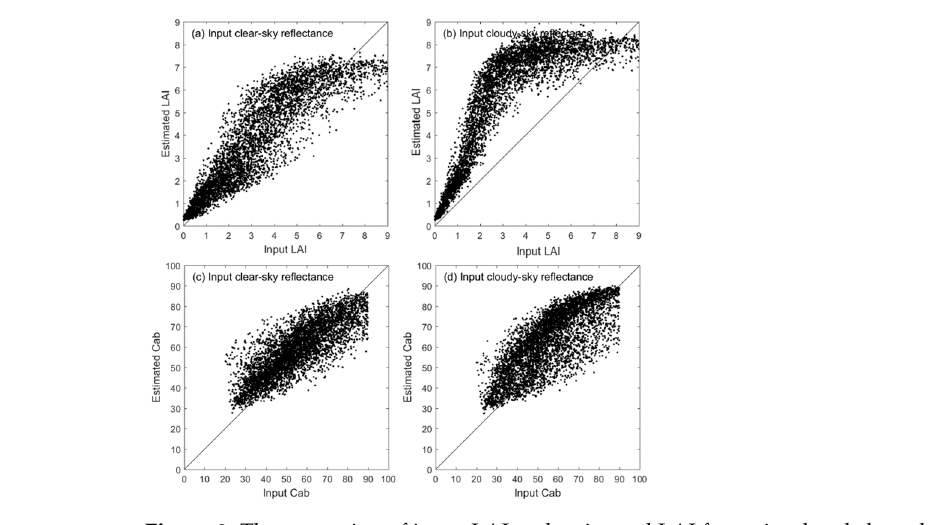
Figure 3. The regression of input LAI and estimated LAI from simulated clear-sky reflectance ( a ) and cloud-sky reflectance ( b ). ( c , d ) are corresponding for C ab (µg ∙ cm − 2 ).